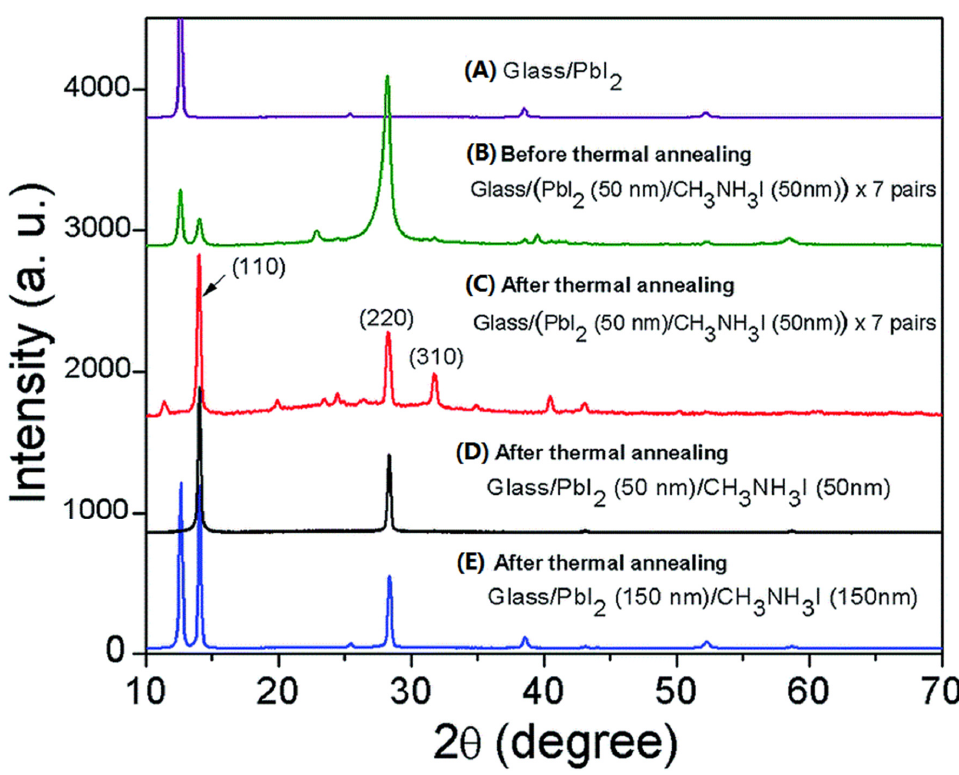
Figure 2. XRD patterns of glass substrates with vapor deposition of ( A ) a layer of PbI 2 ; and ( B ) a layer of PbI 2 followed by a layer of MAI, repeating this step 7 times; XRD pattern of the ( C ) annealed 7-time deposited PbI 2 /MAI layer; ( D ) 1-time deposited PbI 2 (50 nm thickness)/MAI (50 nm thickness) layer; and ( E ) 1-time deposited PbI 2 (150 nm thickness)/MAI (150 nm thickness) layer. Reprinted from reference [77], Copyright © 2015, Royal Society of Chemistry.